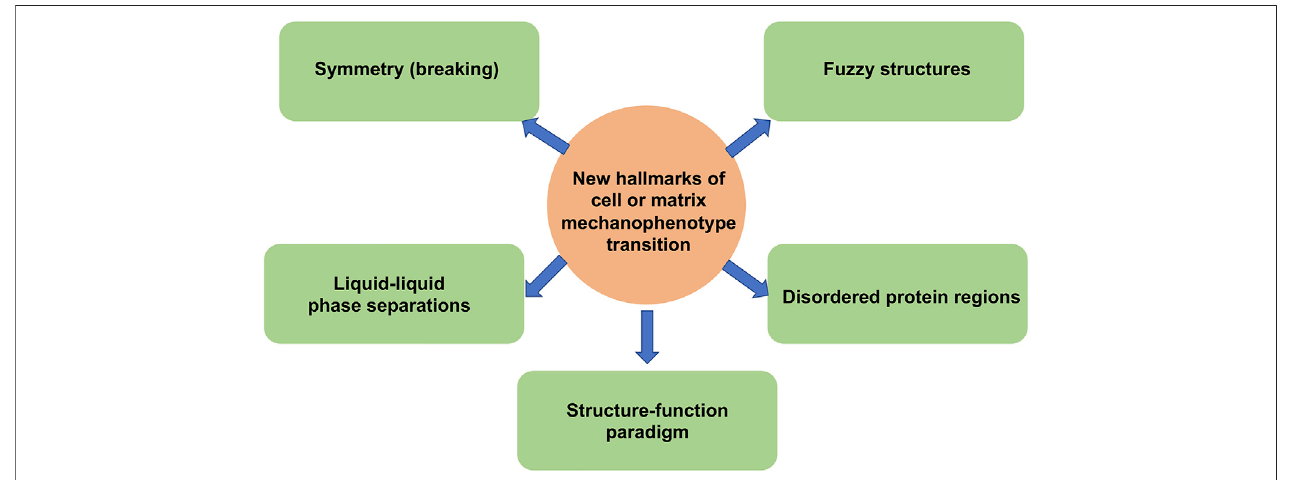
FIGURE 10 | New hallmarks of the mechanophenotype